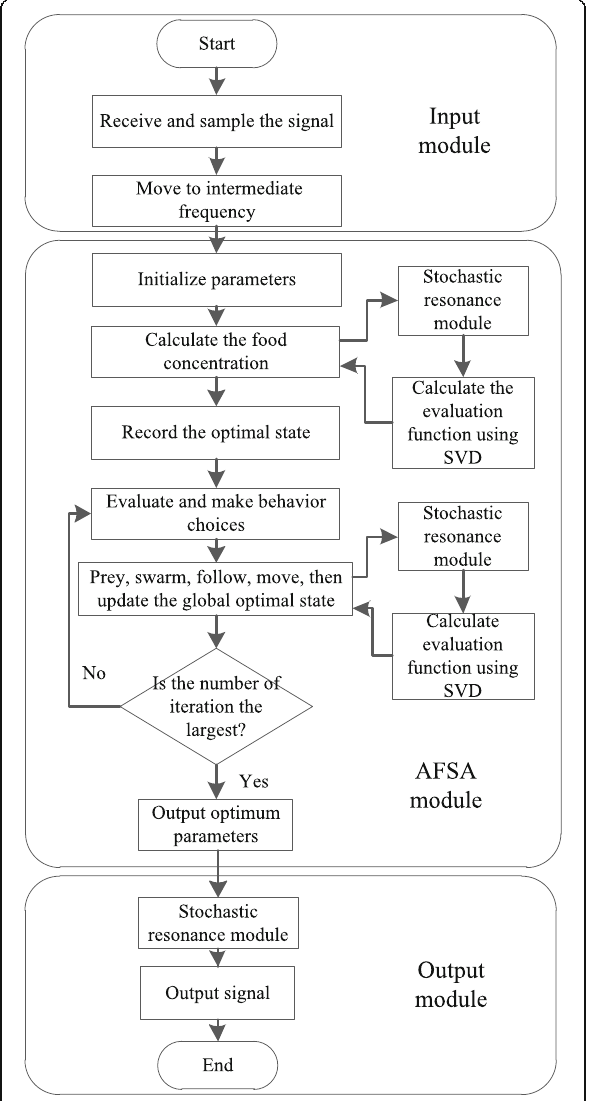
Fig. 9 System composition block diagram